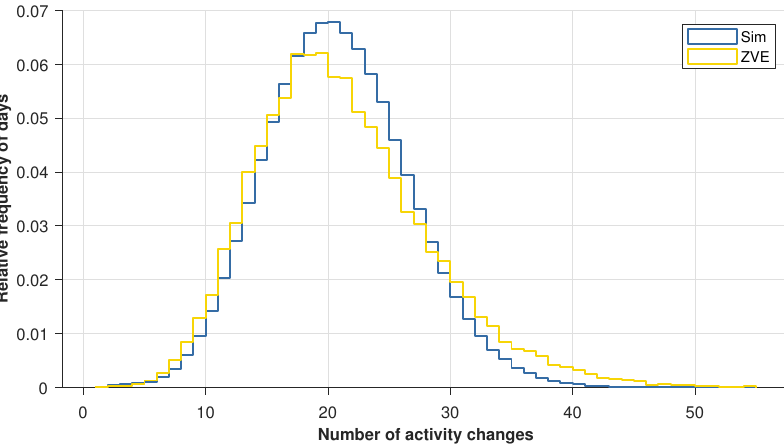
Figure 5. Relative frequency distribution of days with n activity changes of the simulation and the